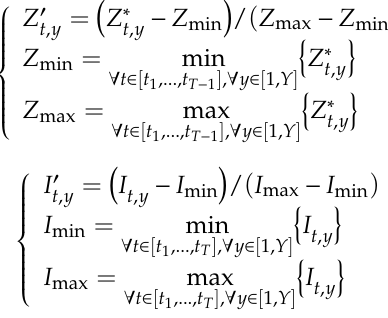
Table 2. The month corresponding to